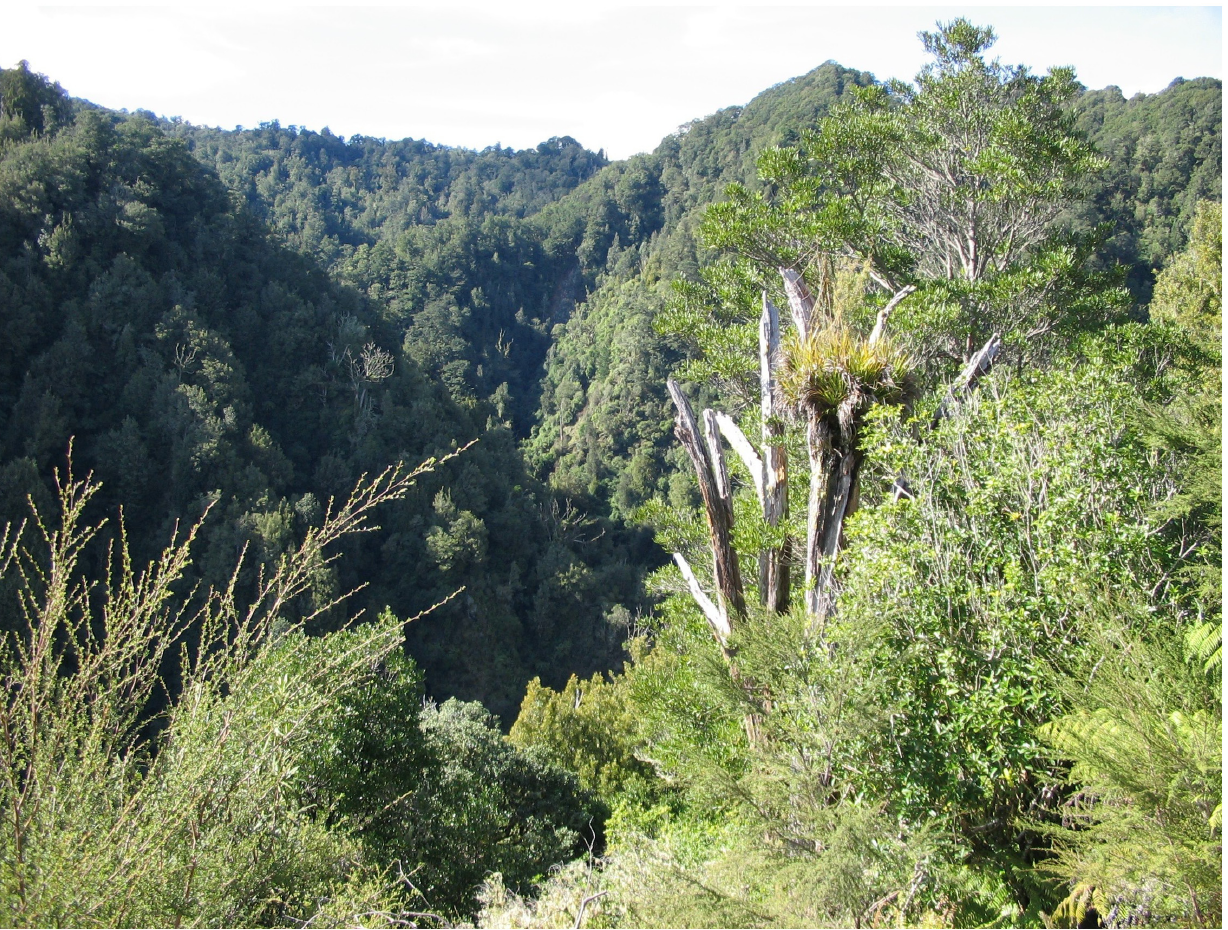
Fig 1. Photograph of Ikawhenua Range, illustrating the topographic diversity and forest cover of our study area. A 400-m elevation gradient occurs from the valley bottoms to ridge crests, forming steep slopes of varying aspects. Kunzea ericoides , a tree species dominating previously burnt forest, is shown in the foreground, with trees of Beilschmiedia tawa and Melicytus ramiflorus dominating the unburnt forest slopes in the background. A grid of camera locations was used to representatively sample the range of sites and determine occupancy by sympatric tropical and temperate deer species.